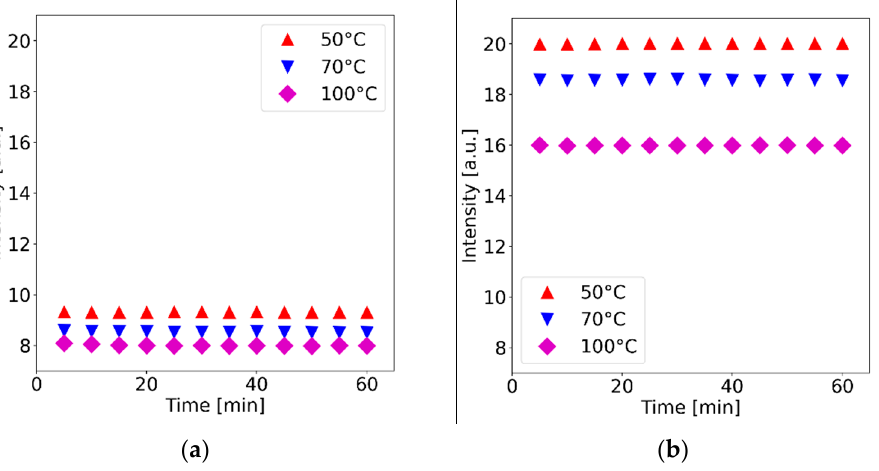
Figure 5. Fluorescence stability at different temperatures for PDMS-YbEr membranes of: ( a ) 150 μ m thickness and 1.5% concentration and ( b ) 300 μ m thickness and 2.5% concentration.